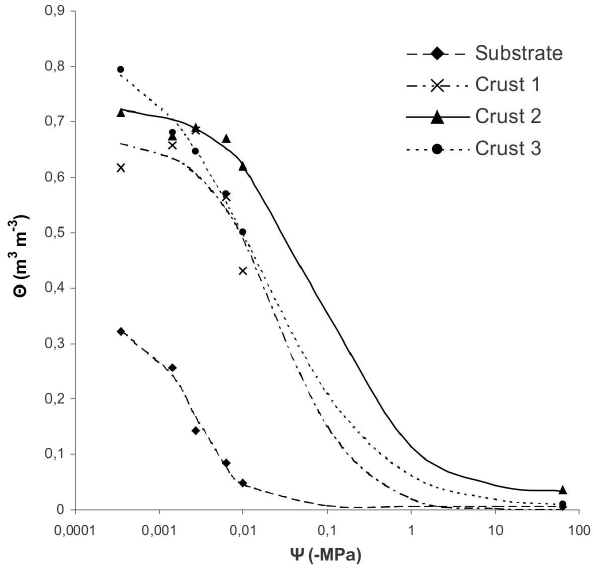
Fig. 1. Water retention curves of the initial substrate and the BSCs. 9 is the soil water potential; 2 is the volumetric water content. Arithmetic mean values with n = 3.